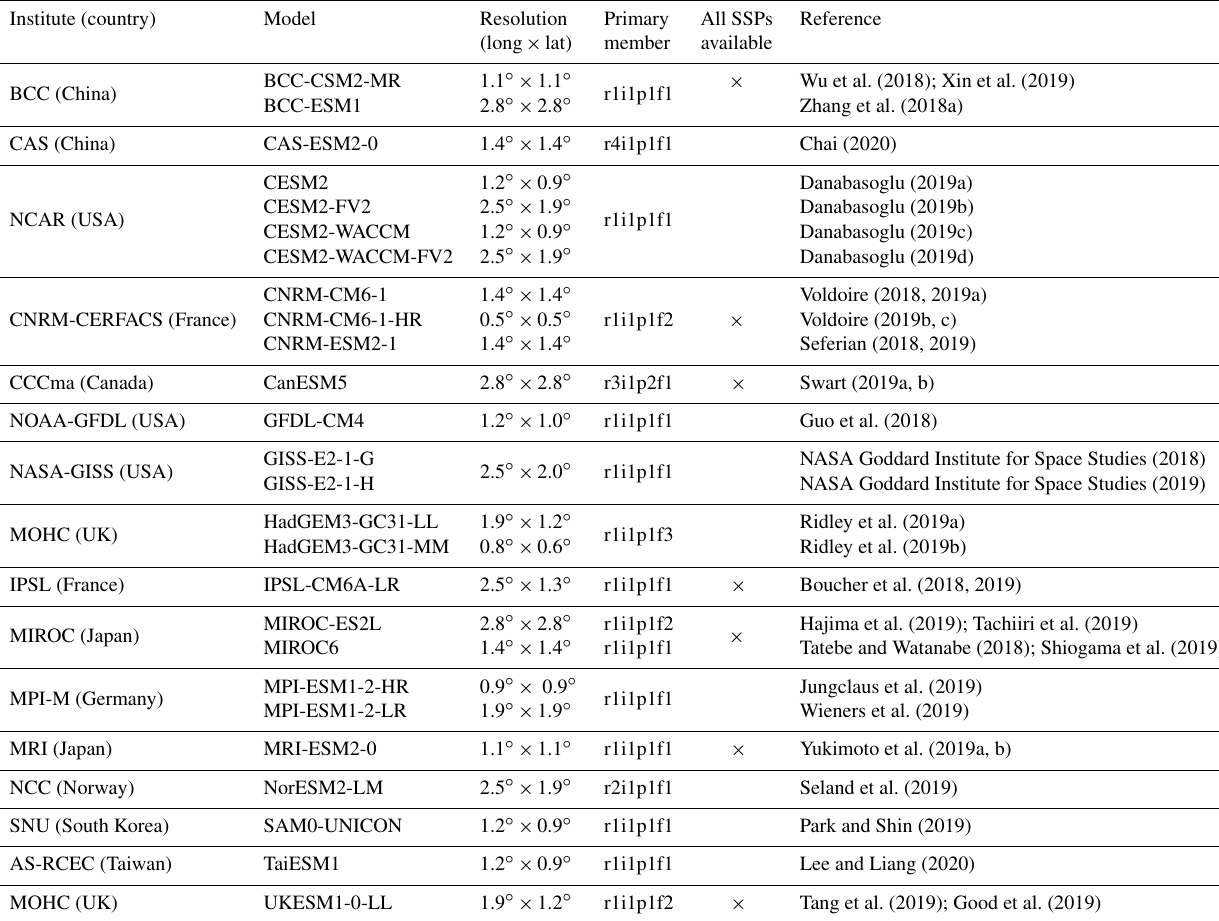
Table 1. Description of the CMIP6 models used in this study with their institute, name, approximate spatial resolution (longitude × latitude), the member considered in the one-member analyses and their reference. A cross is included in the last column when the model projections are available for the four SSP scenarios (SSP1-2.6, SSP2-4.5, SSP3-7.0 and